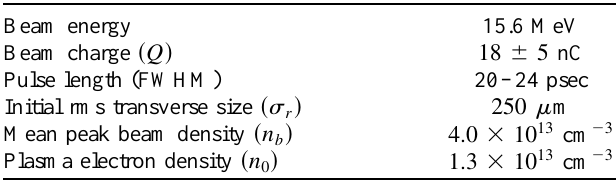
TABLE I. Experimental parameters for blowout regime plasma wakefield acceleration experiment at the AWA. Beam